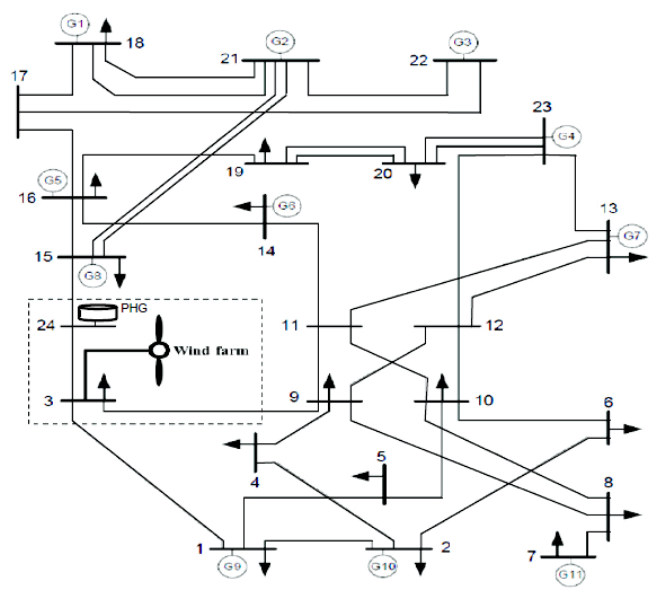
Figure 8. Modified IEEE24-RTS with wind generation and Pumped Hydro Generation